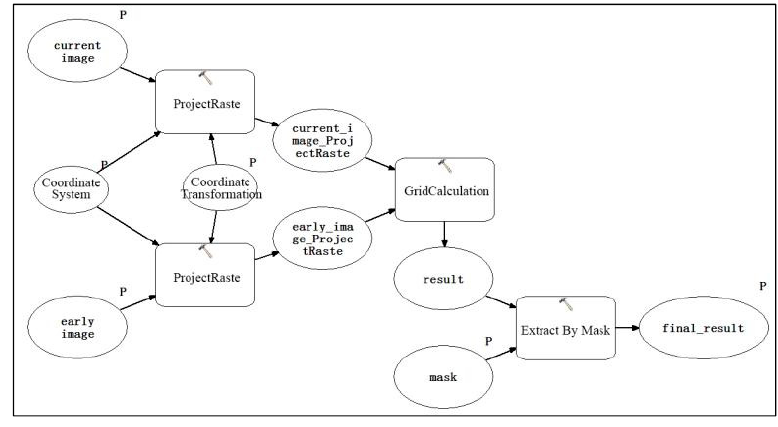
Figure 2. Automatic extraction flow chart of building elevation change detection.